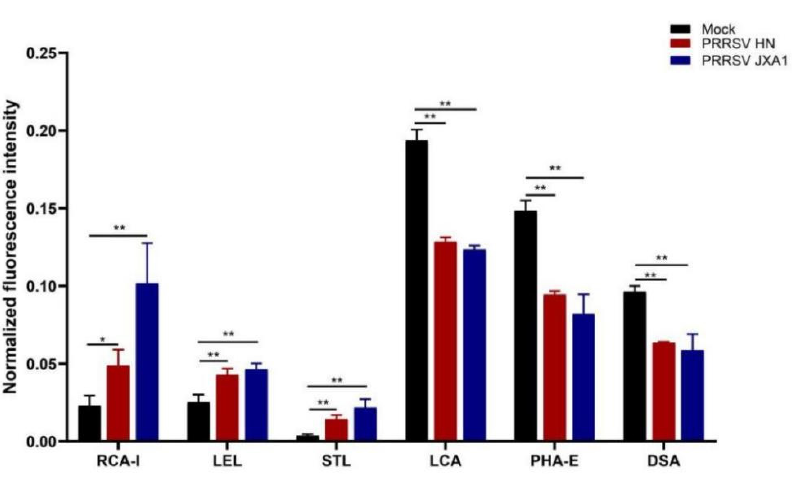
Figure 6. Differentially expressed lectin sites in both HP-PRRSV strain-infected PPMVECs. Statistical analysis was performed by Student’s t -test. * p < 0.05; ** p < 0.01.